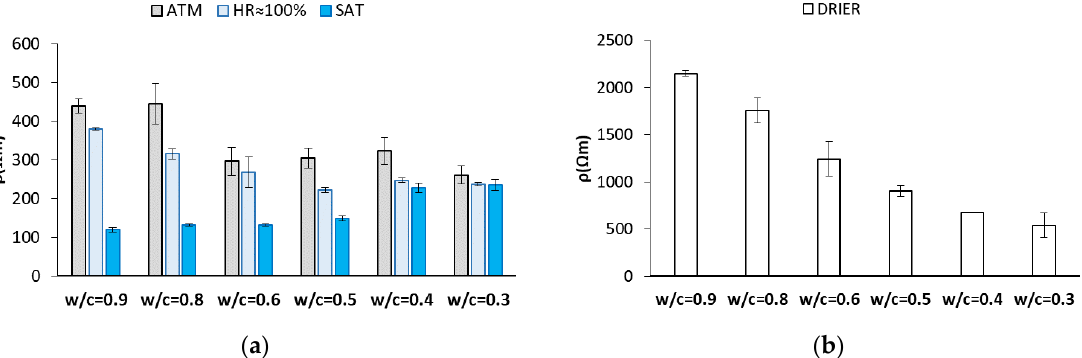
Figure 9. Average electric resistivity values obtained in the validation samples without sensors. ( a ) ATM: laboratory humidity and temperature conditions. HR ≈ 100%: reference condition for weights. SAT: samples immersed under the water condition. ( b ) Drier: condition of the samples dried at 50 ◦ C and left in the drier to cool with salt.